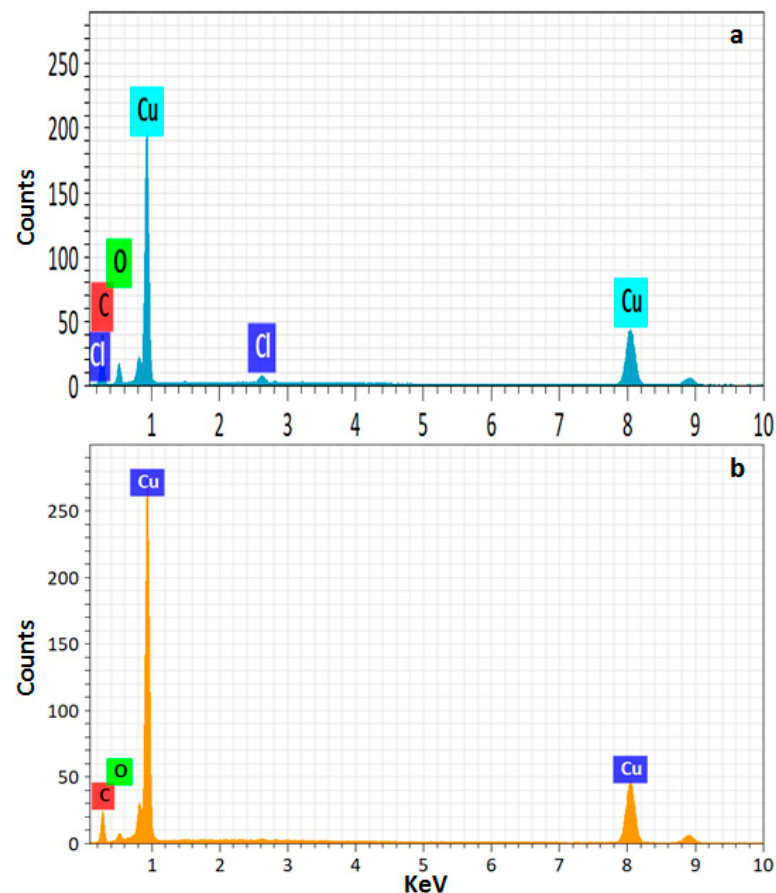
Figure 5. Energy-dispersive X-ray spectroscopy (EDX) spectra of copper dipped in ( a ) 1 M HCl and ( b ) 1 M HCl with 1000 ppm of